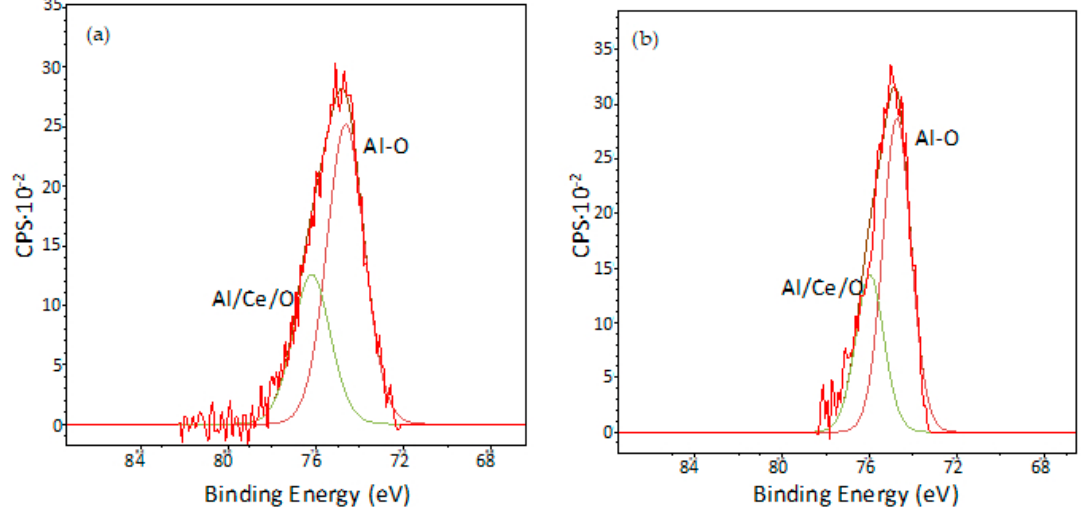
Figure 14. XPS spectra of Al2p. ( a ) CeCC-1. ( b ) CeCC-2.